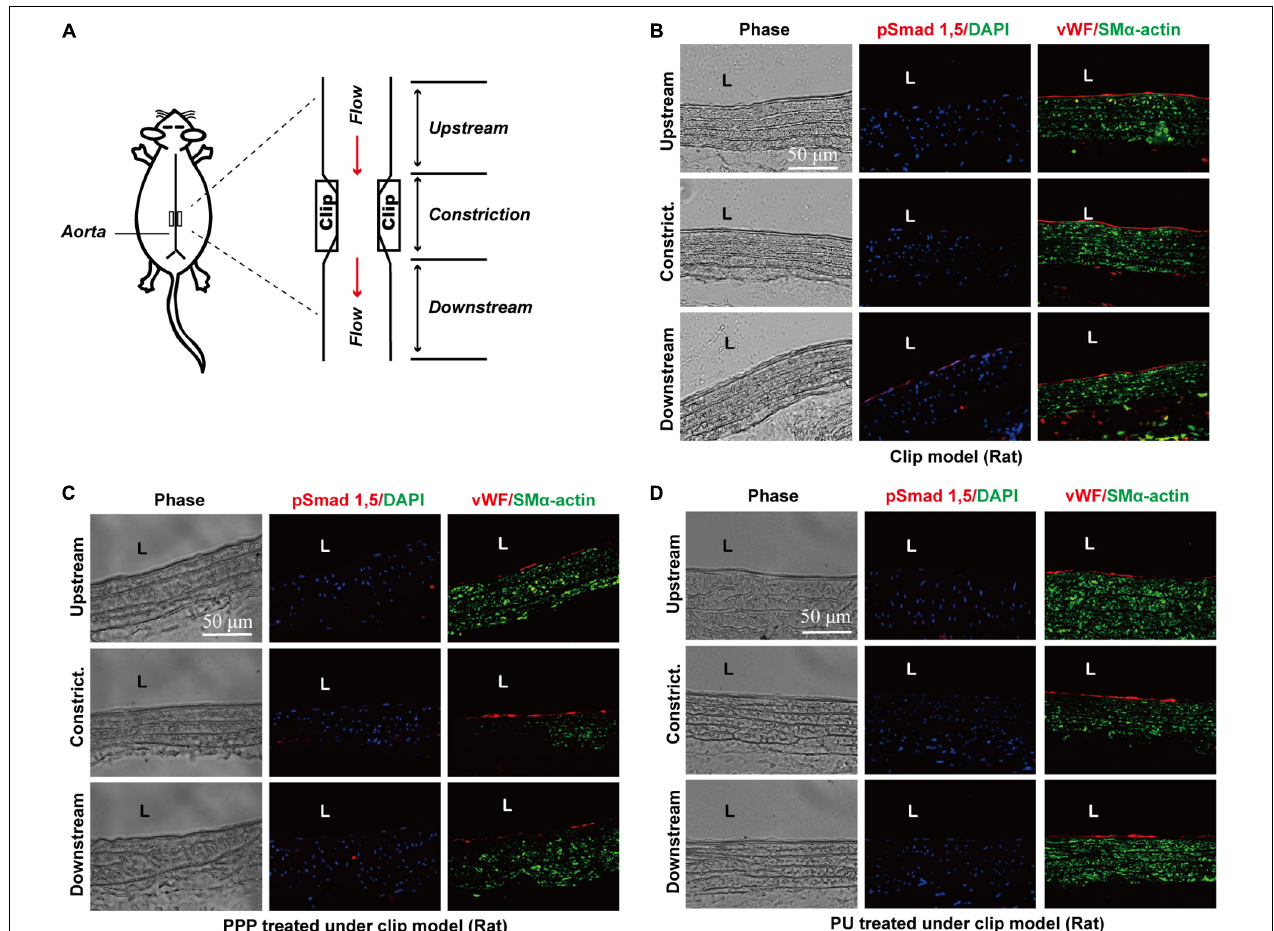
FIGURE 4 | PPP and PU inhibit force-specific activation of Smad1/5 in ECs induced by disturbed flow in vivo . A rat model with abdominal aortic stenosis was established by partially constricting rat abdominal aorta using a U-clip (A) . Protein expressions of phospho-Smad1/5/vWF/SM α -actin in the upstream, middle point, and downstream areas of the constricted sites were detected by immunofluorescence staining. (B) saline treatment group, (C) PPP treatment group, and (D) PU treatment group (five independent experiments performed).